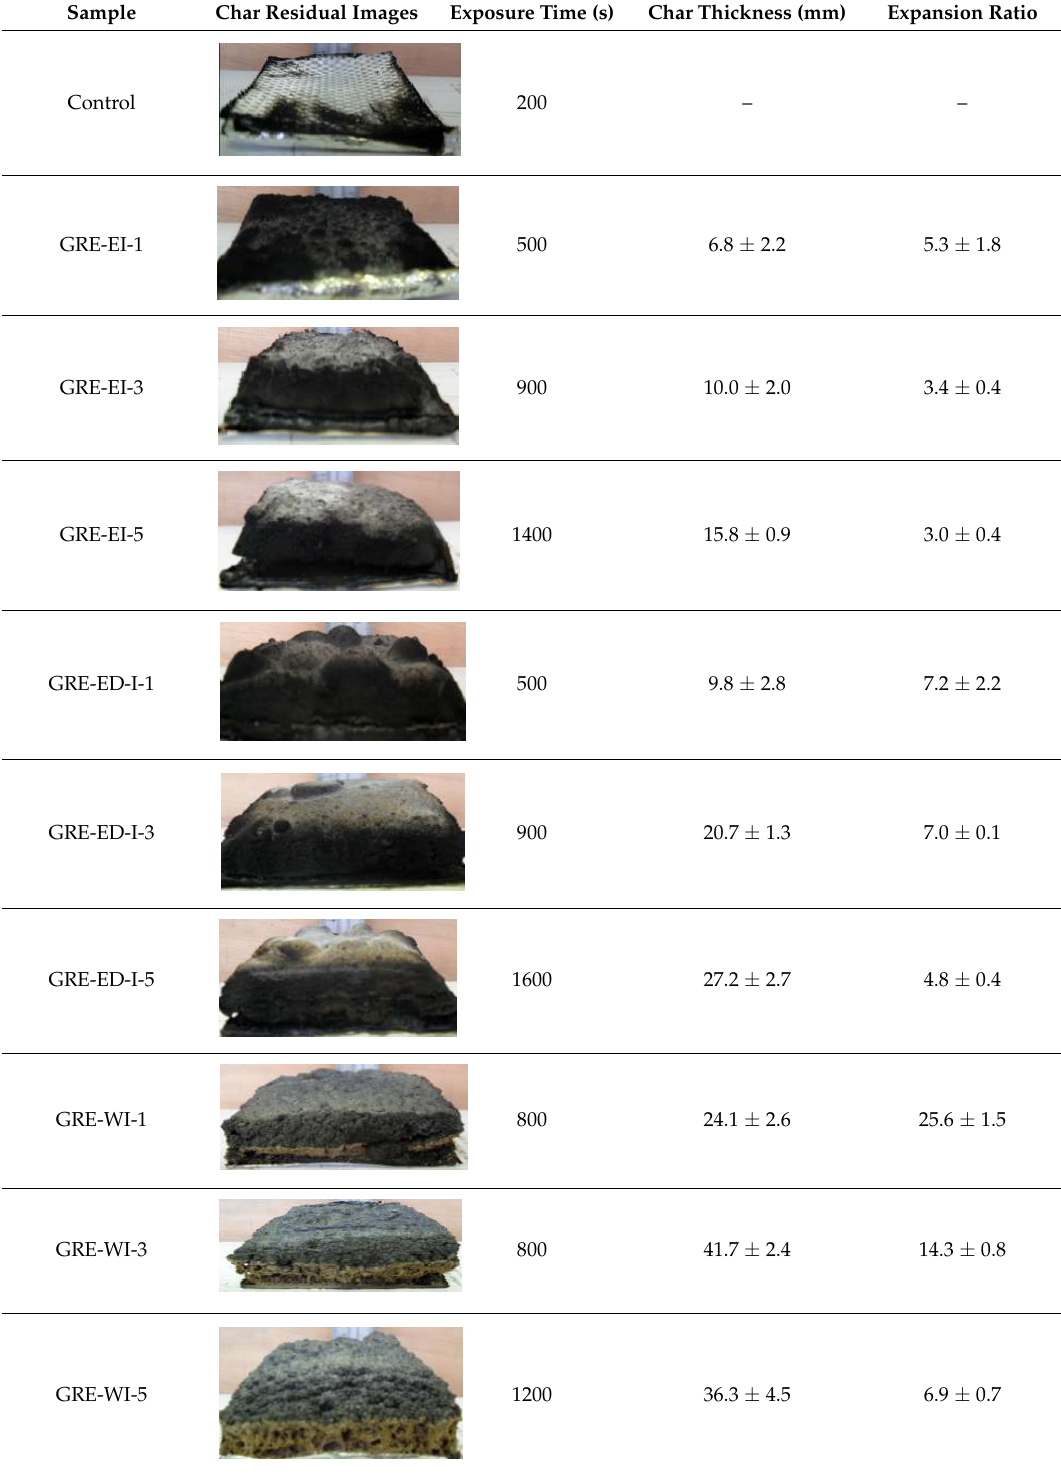
Table 2. Digital images and thicknesses of residual char obtained at the end of cone calorimeter experiment of control and intumescent coated GRE composites (data taken from [16]).